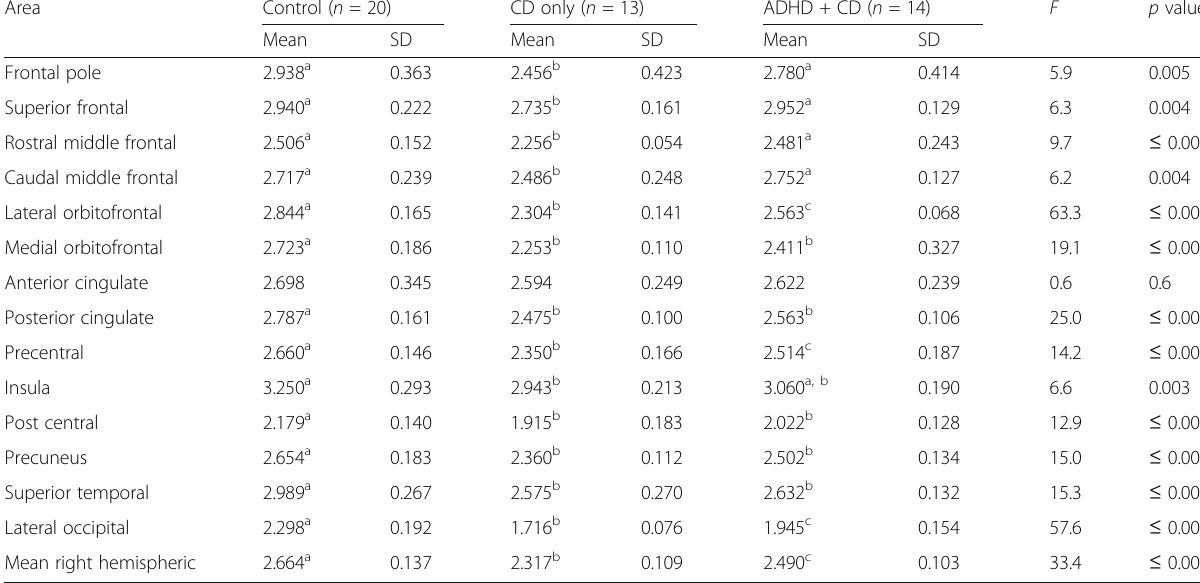
Table 2 Comparison between adolescents with conduct disorder, with and without ADHD, and control adolescents regarding right hemispheric cortical thickness (mm)